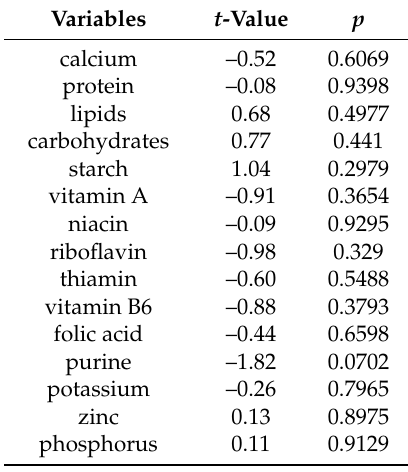
Table A1. Comparison between the two schools at baseline: T -test